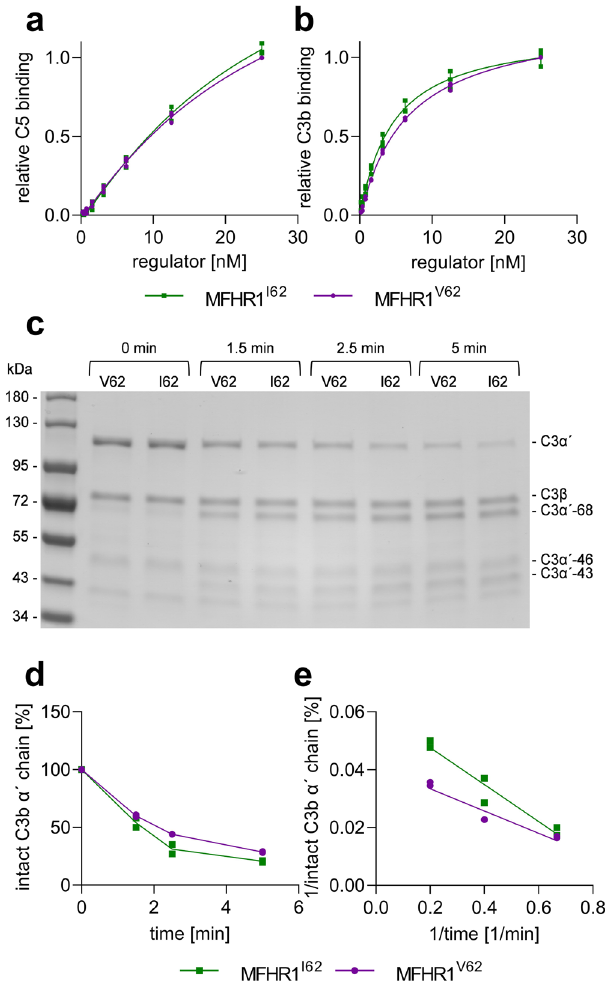
Fig. 2 MFHR1 I62 displays better C3b binding and cofactor activity than MFHR1 V62 . a Binding to immobilized C5 was evaluated by ELISA with increasing concentrations of MFHR1 I62 and MFHR1 V62 . Nonlinear regression using the sigmoidal equation and logarithmic transformed data showed no signi fi cant differences between both variants binding to C5 ( P = 0.9328). Data represent mean values± SD from 3 independent experiments. b Binding to immobilized C3b was evaluated by ELISA with increasing concentrations of MFHR1 I62 and MFHR1 V62 . Nonlinear regression using the sigmoidal equation (dose – response curve, 4 parameters) showed signi fi cant differences between both variants binding to C3b ( P = 0.0437). Data from one representative experiment are shown in Supplementary Fig. 7. c Cofactor activity of FI-mediated proteolytic cleavage of C3b α ′ -chain in the presence of MFHR1 I62 or MFHR1 V62 was visualized by SDS-PAGE and Coomassie staining. One representative experiment is shown. d Densitometric analysis of C3b cleavage. The amount of intact α ′ -chain was normalized for each sample with the β -chain and set to 100% intact C3b α ′ -chain at time zero. Two independent experiments were included in the analysis. e Double reciprocal plot of the percentage of intact C3b α ′ -chain. Linear regression analysis indicated signi fi cant differences between the MFHR1 variants ( P =